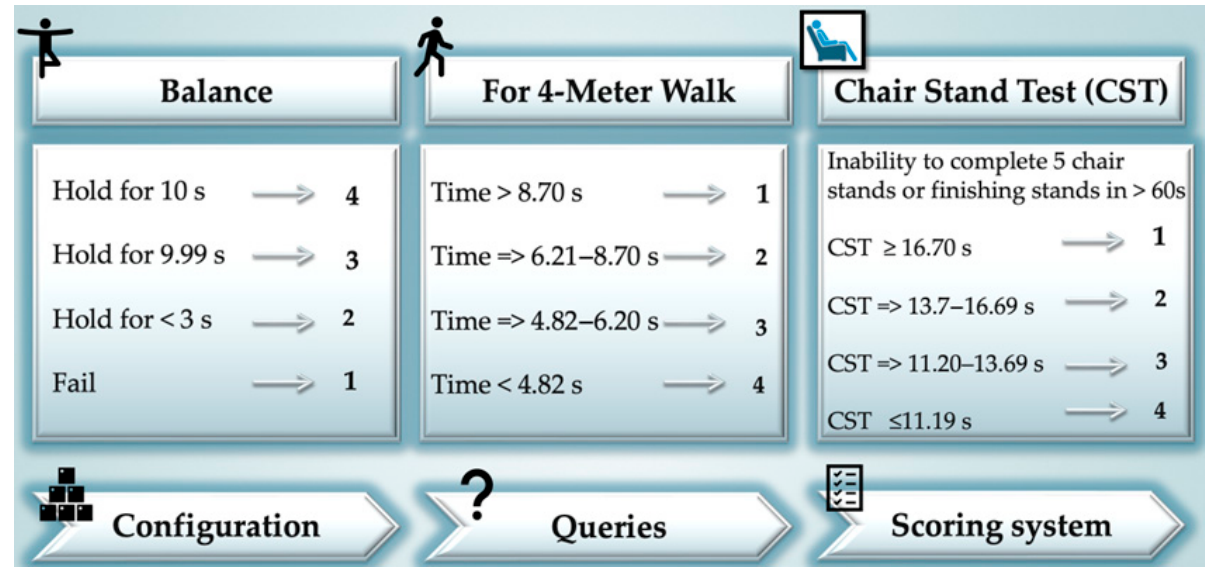
Figure 3. Short Physical Performance Battery Protocol and Score Sheet (SPPB), summarized considering [27].